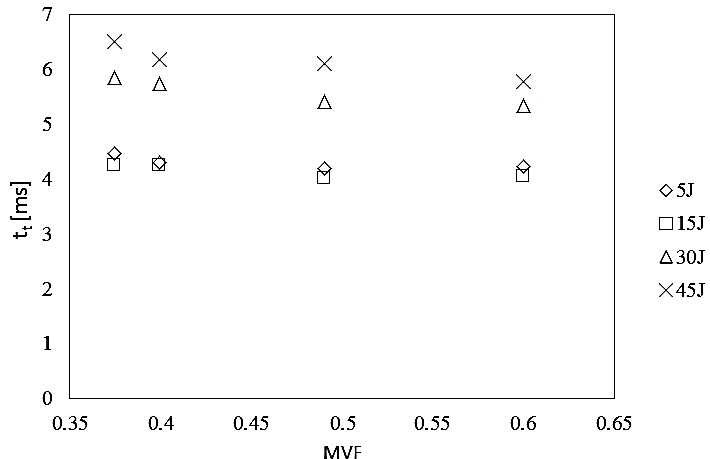
Figure 4. The dependence between total impact time and metal volume fraction in HTCL for different impact energies.